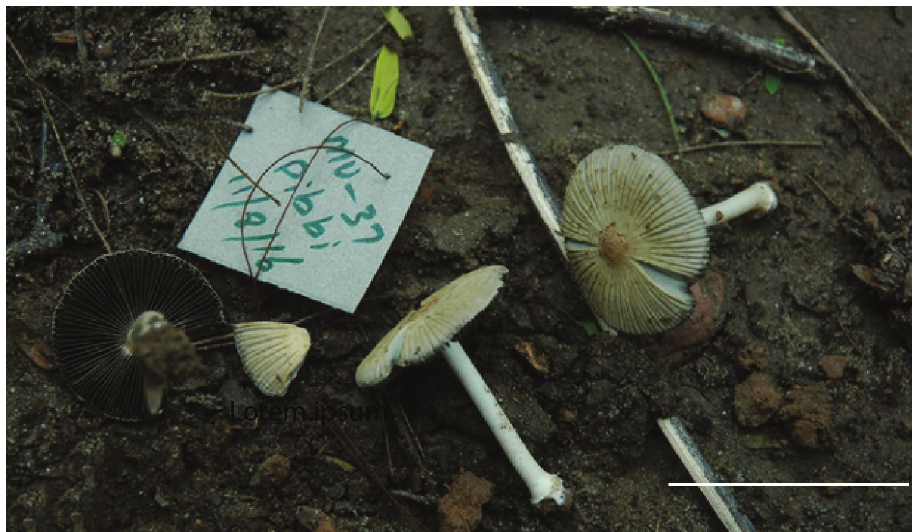
Figure 2. Basidiomata of Coprinellus pakistanicus Holotype (MU37). Scale bar: 20